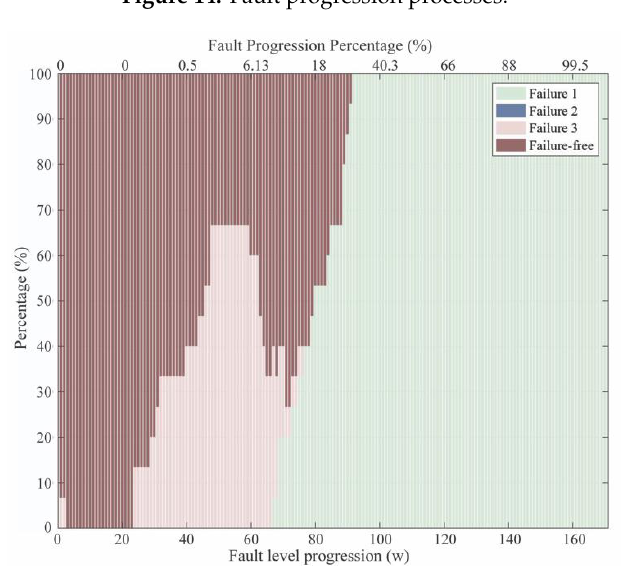
Figure 15. Evolution of failure prediction for failure-leak (𝐹 1 ) .